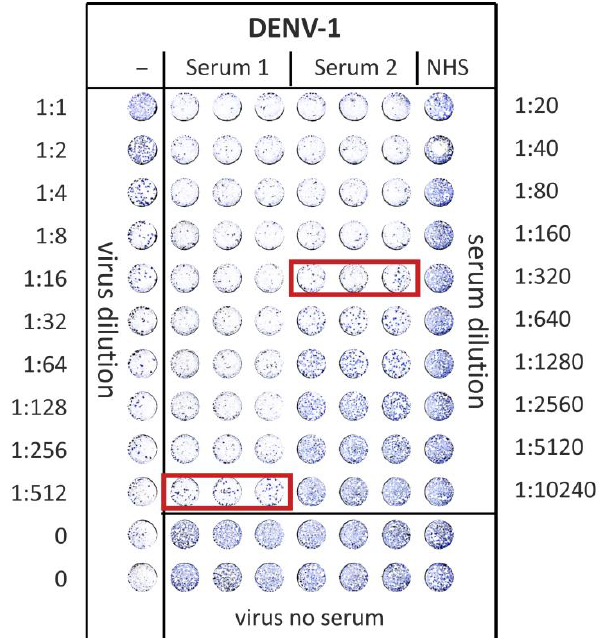
Figure A1. Original data from a 96-well microplate of a DENV-1 neutralization test. The red frame indicates the serum dilution showing >90% neutralization. NHS, normal human serum; -, no serum added; virus no serum, the input virus for serum 1, serum2 and NHS,